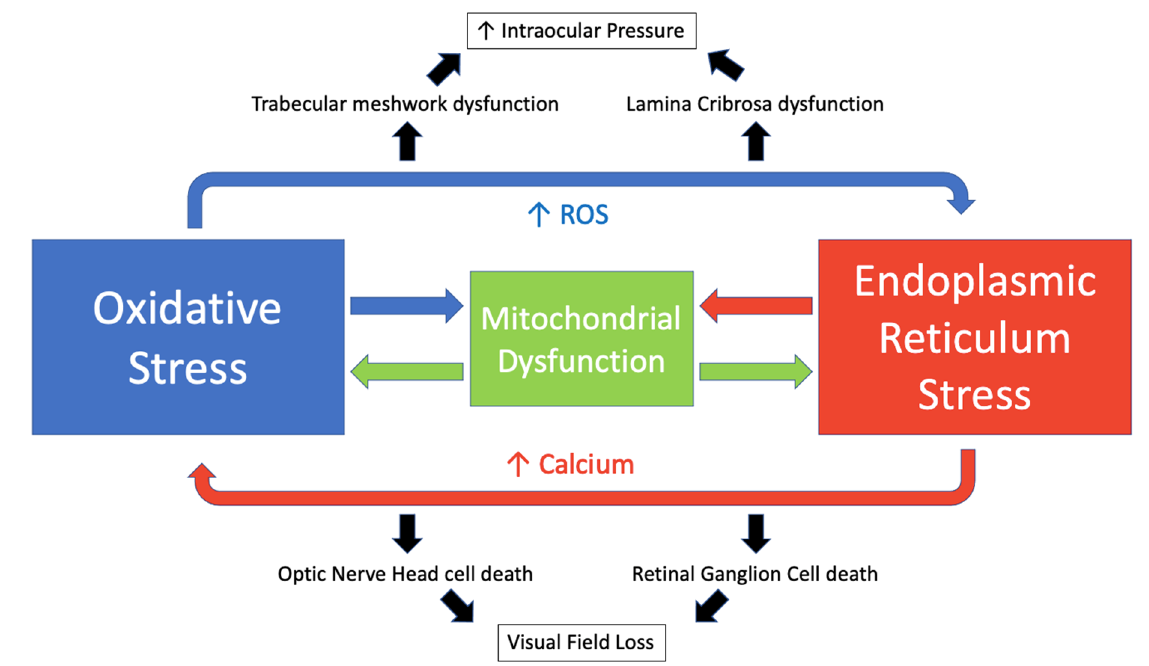
Figure 5. The interplay of oxidative stress and endoplasmic reticulum stress in glaucoma. Approximately 25% of ROS generated in the cell are derived from the ER [234]. An increase in ROS may also lead to activation of the UPR [235]. ATF4, which promotes ab- errant protein synthesis, has been linked to oxidative stress in several studies [236,237]. Kasetti et al. have shown that induced over-expression of ATF4 leads to increased ROS expression in human TM cells [176], while a study by Kuk Joe et al. found that the expres- sion of myocilin mutants in human TM cells resulted in ER stress which sensitised cells to oxidative stress-induced apoptosis [238]. This interplay has also been described in multi- ple neurodegenerative diseases [239], cancer [240,241], diabetes mellitus [242], cardiovas- cular disease [243] and other diseases. The evidence of oxidative and ER stress in glaucoma, at multiple sites, represents a new avenue of therapeutic potential. Given the cyclical nature of the processes, both may be targeted by one agent as evidenced by a study showing that an overexpression of the